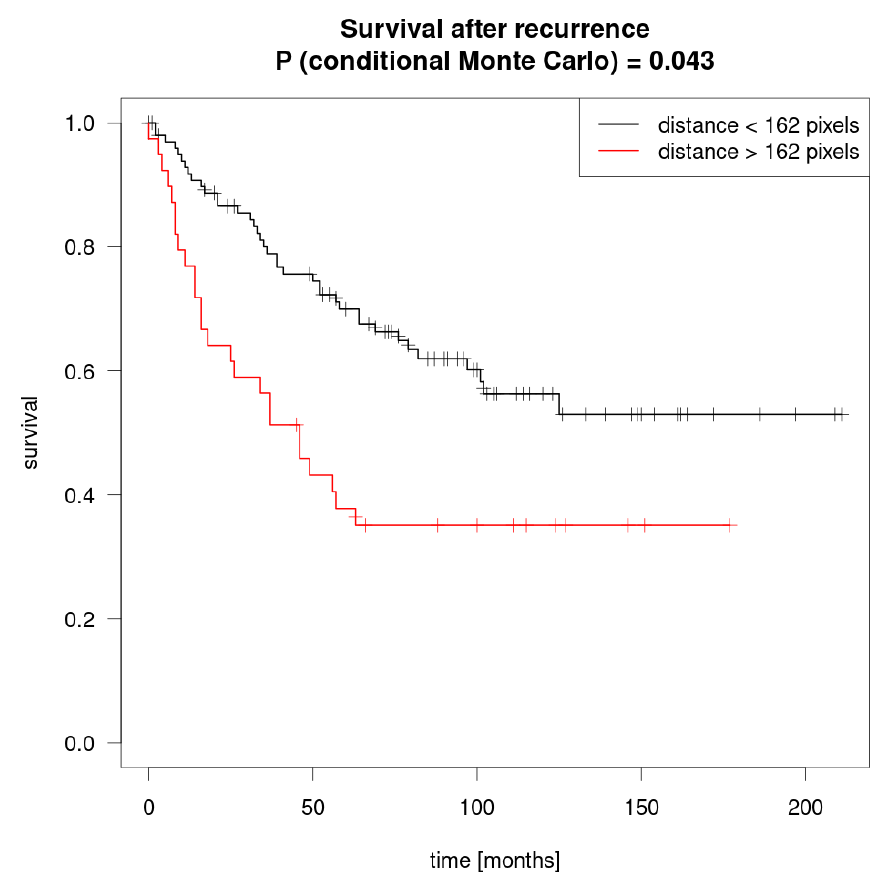
Figure 2. Kaplan–Meier curve for mean survival (months) by